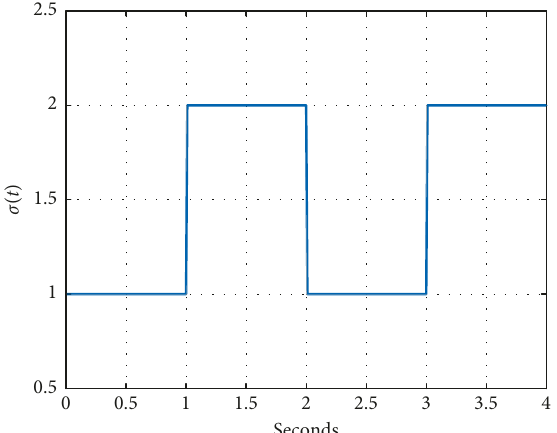
Figure 2: Switching signal σ ( t ) in simulation.